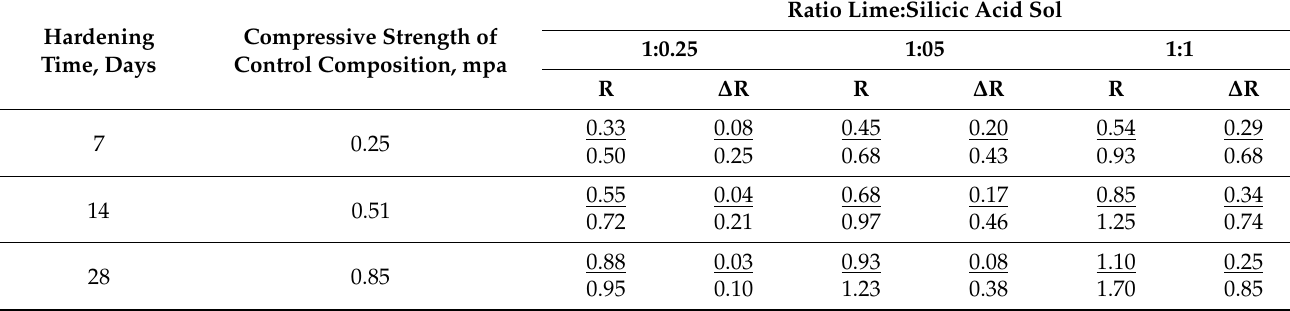
Table 4. Values of compressive strength R,